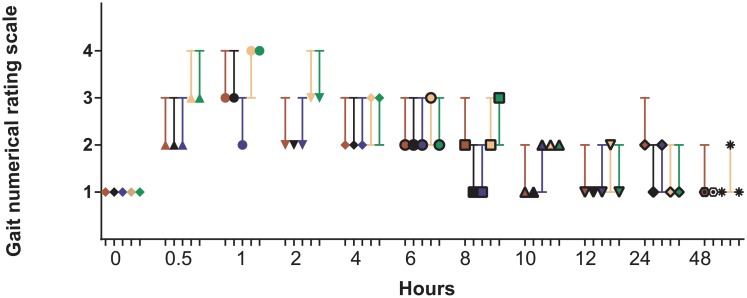
Gait score for controls and all four meloxicam treatment groups.Symbol denotes median, lower bar is 25% quartile; upper bar is 75% quartile. If no upper or lower bar than that missing limit is the same as the median. Symbol and bars: red = control treatment, black = 1 mg/kg SC, blue = 2 mg/kg SC, tan = 1 mg/kg IM, green = 2 mg/kg IM.